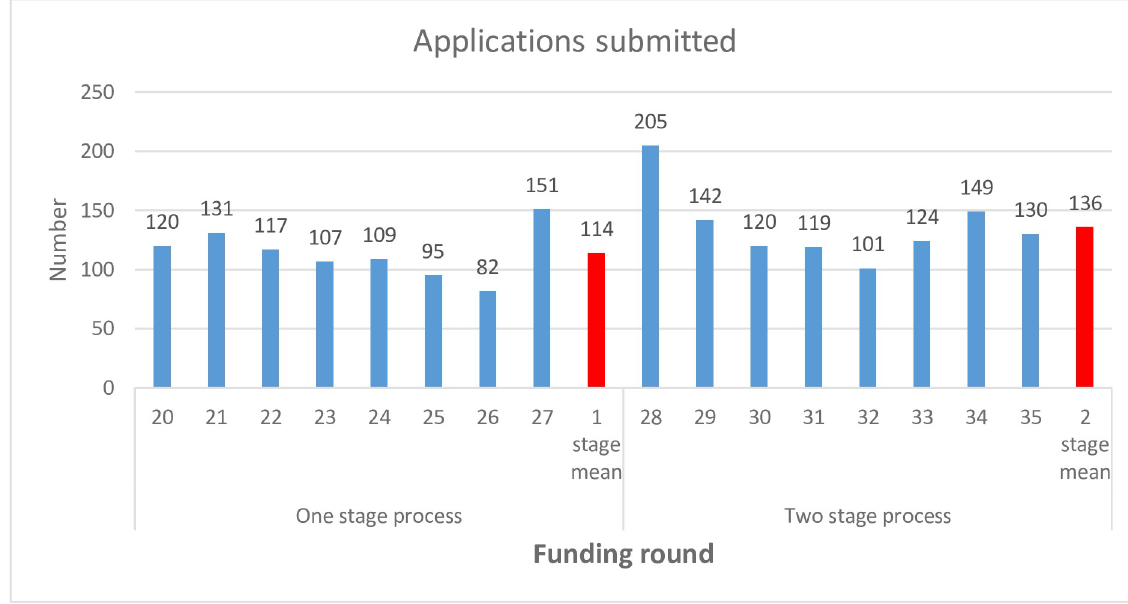
Fig 4. Total applications submitted between funding rounds 20 and 35.